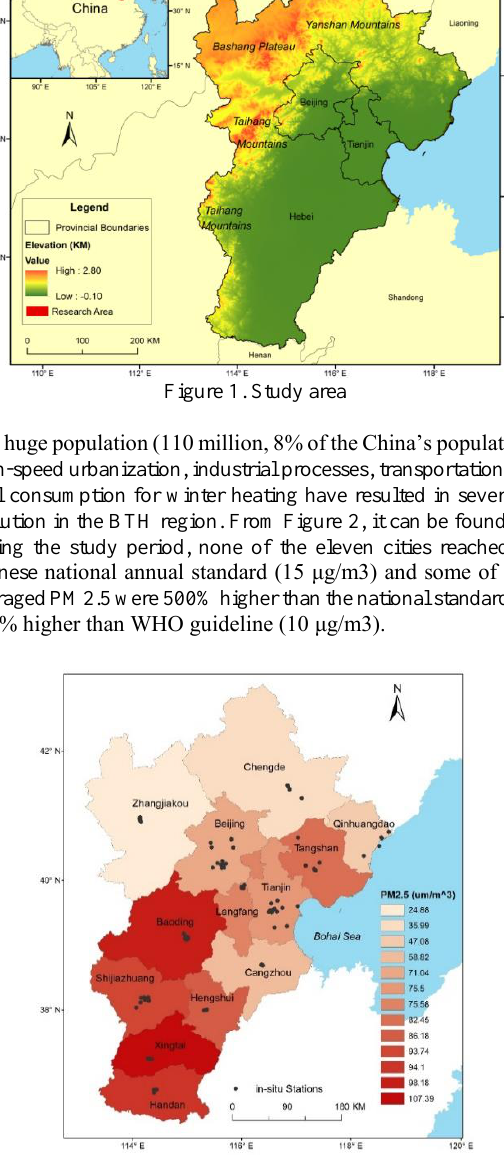
Figure 2 ground level monitoring stations’ locations and the averaged PM2.5 of each city during the study period However, trapped by surrounding mountains and plateau, air pollutant in BTH accumulate easily. From Figure 1, it can be noticed that the BTH region has a complex topography with three geographic units: North China Plain, Yan Mountains and Taihang Mountains, and Bashang Plateau. As shown in Figure 1, most of the southeastern and central BTH region lie on the North China Plain. Taihang Mountains run through the western BTH region while Yan Mountains range surround the BTH region from north. Bashan Plateau, located in the northern part of Zhangjiakou and Chengde, is the southeastern edge of the Mongolian Plateau. Therefore, only the northwest wind could dissipate air pollutant while the southeast wind helps to accumulate air pollutant in the BTH